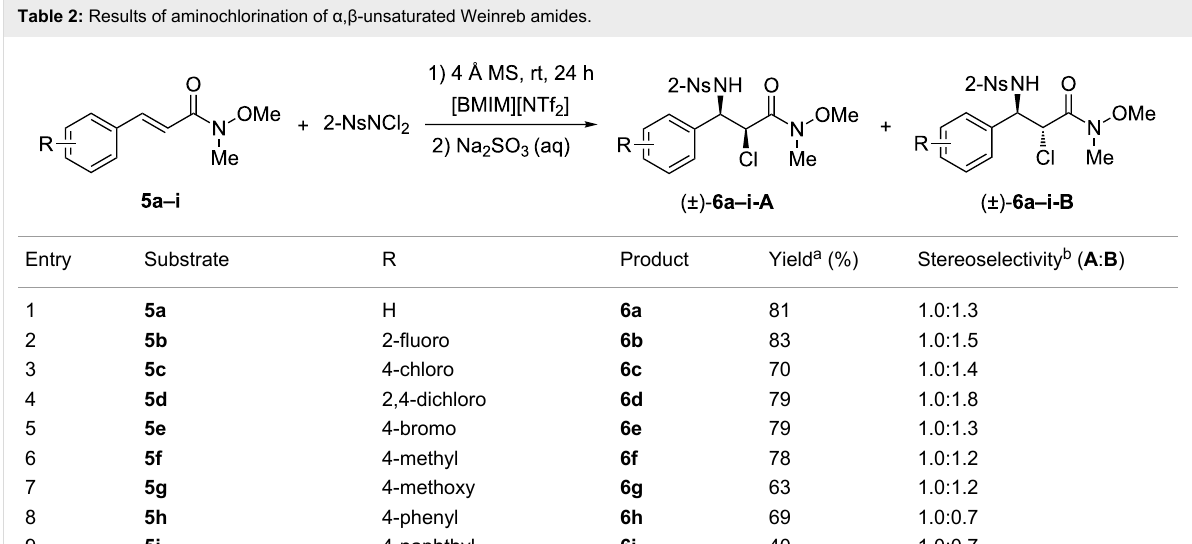
Table 2: Results of aminochlorination of α , β -unsaturated Weinreb